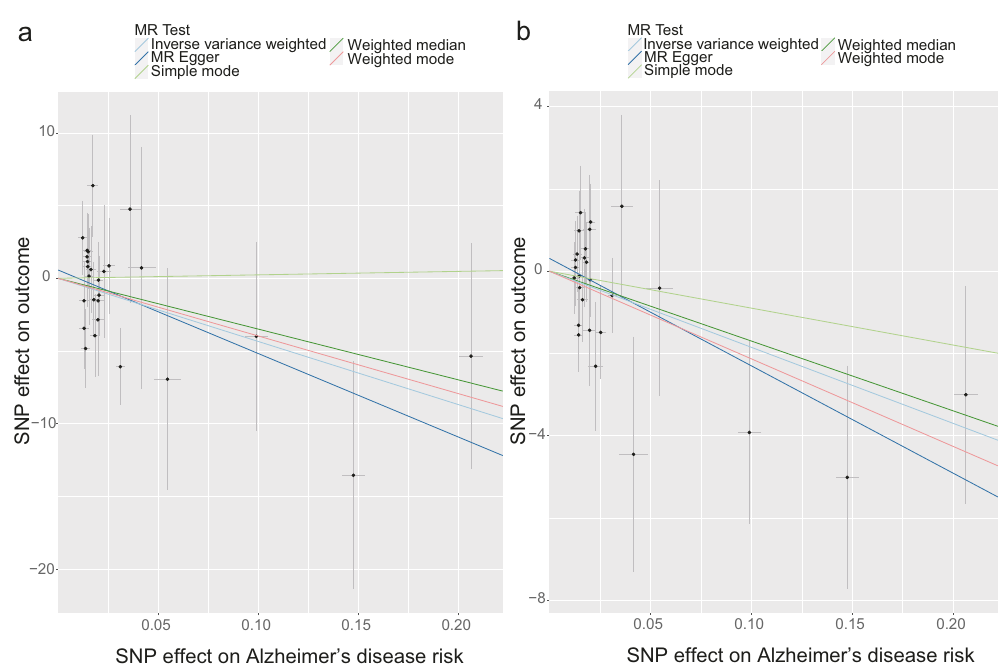
Fig. 5 Scatterplot of single-nucleotide polymorphism (SNP) associated with Alzheimer ’ s disease and cortical structure. a Scatterplot of SNP associated with AD versus the cortical surface area of precentral. b Scatterplot of SNP associated with AD versus cortical surface area of isthmus cingulate. AD Alzheimer ’ s disease, SNP single-nucleotide polymorphism. Vertical and horizontal lines around each SNP show 95% con fi dence